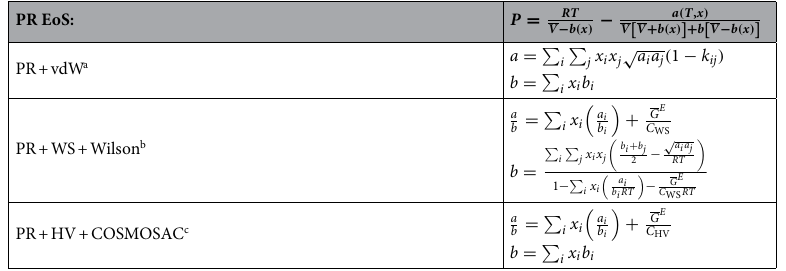
Table 5. Investigated PR EoS based thermodynamic models. *a i and b i are determined from critical temperature, critical pressure, and acentric factor of component i as described in the literature 50 . a k ij is an adjustable binary interaction parameter. b C WS = ln from the Wilson model 62 : G binary interaction parameters. c C HV = ln ( 2 ) 63 . Excess Gibbs energy G model 58,59 without any system-specific adjustable parameter.